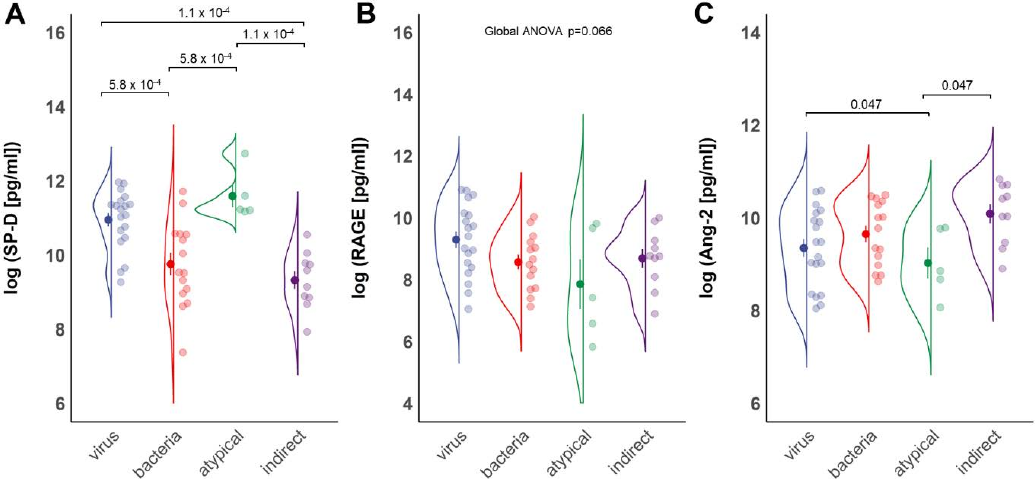
Figure 1. Serum SP-D and Ang-2 levels differ in patients with different ARDS sub-phenotypes. Blood samples of patients with ARDS were obtained and analyzed via multiplex immunoassay. Patients with ARDS caused by viral ( n = 19), bacterial ( n = 15), and atypical pathogen pneumonia ( n = 5) were included. The group of indirect ARDS comprises 10 patients. ( A , B ) SP-D and RAGE concentrations in patients with ARDS of viral, bacterial, and atypical pathogen geneses and indirect ARDS. ( C ) Ang-2 levels in the same patient groups. Mean ± SD of log-transformed data is shown, pairwise t -tests with Benjamini–Hochberg adjustment after global ANOVA.